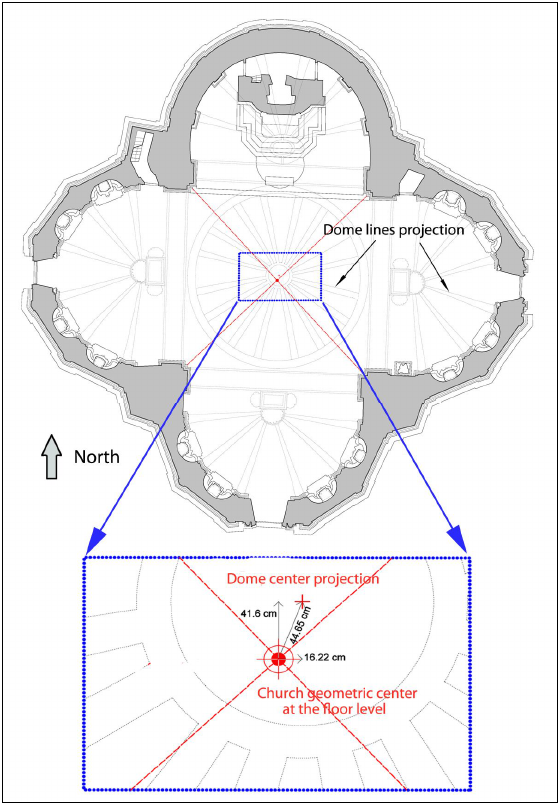
Figure 12. Vertical projection of the dome center on the floor